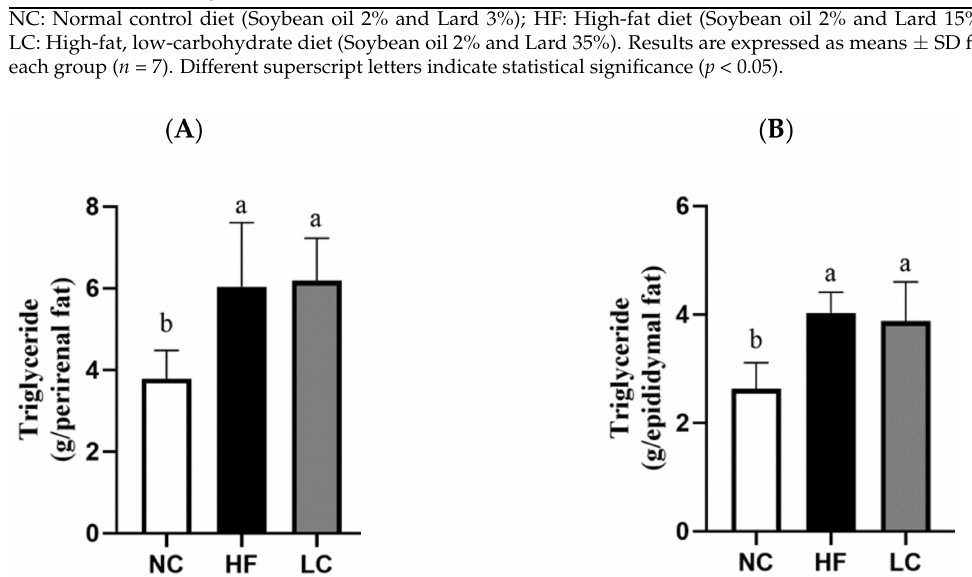
Figure 2. The triglyceride concentration in perirenal and epididymal adipose tissue of rats fed with different experimental diets for 11 weeks. The levels of triglyceride in ( A ) perirenal and ( B ) epididymal adipose are shown. Results are expressed as the mean ± SD for each group ( n = 7). Values with different letters are significantly different, p <